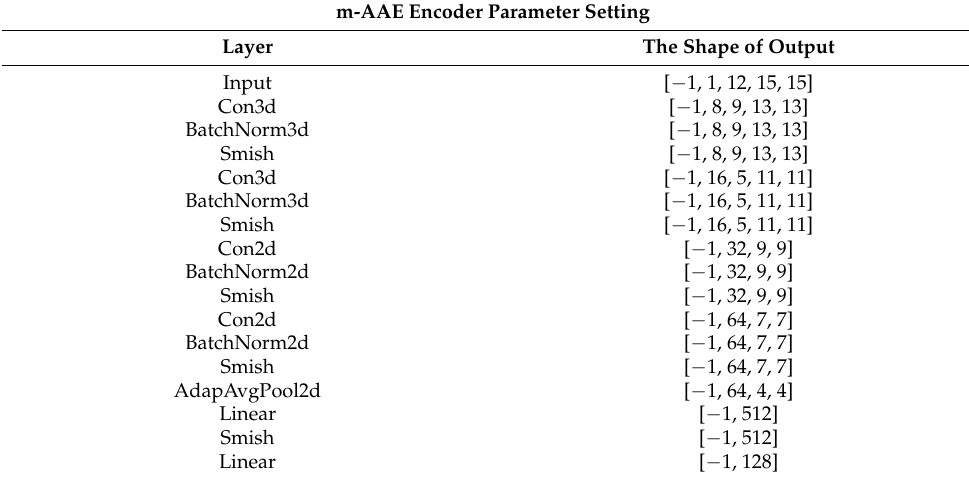
Table 4. The shape of layers in the m-AAE model for